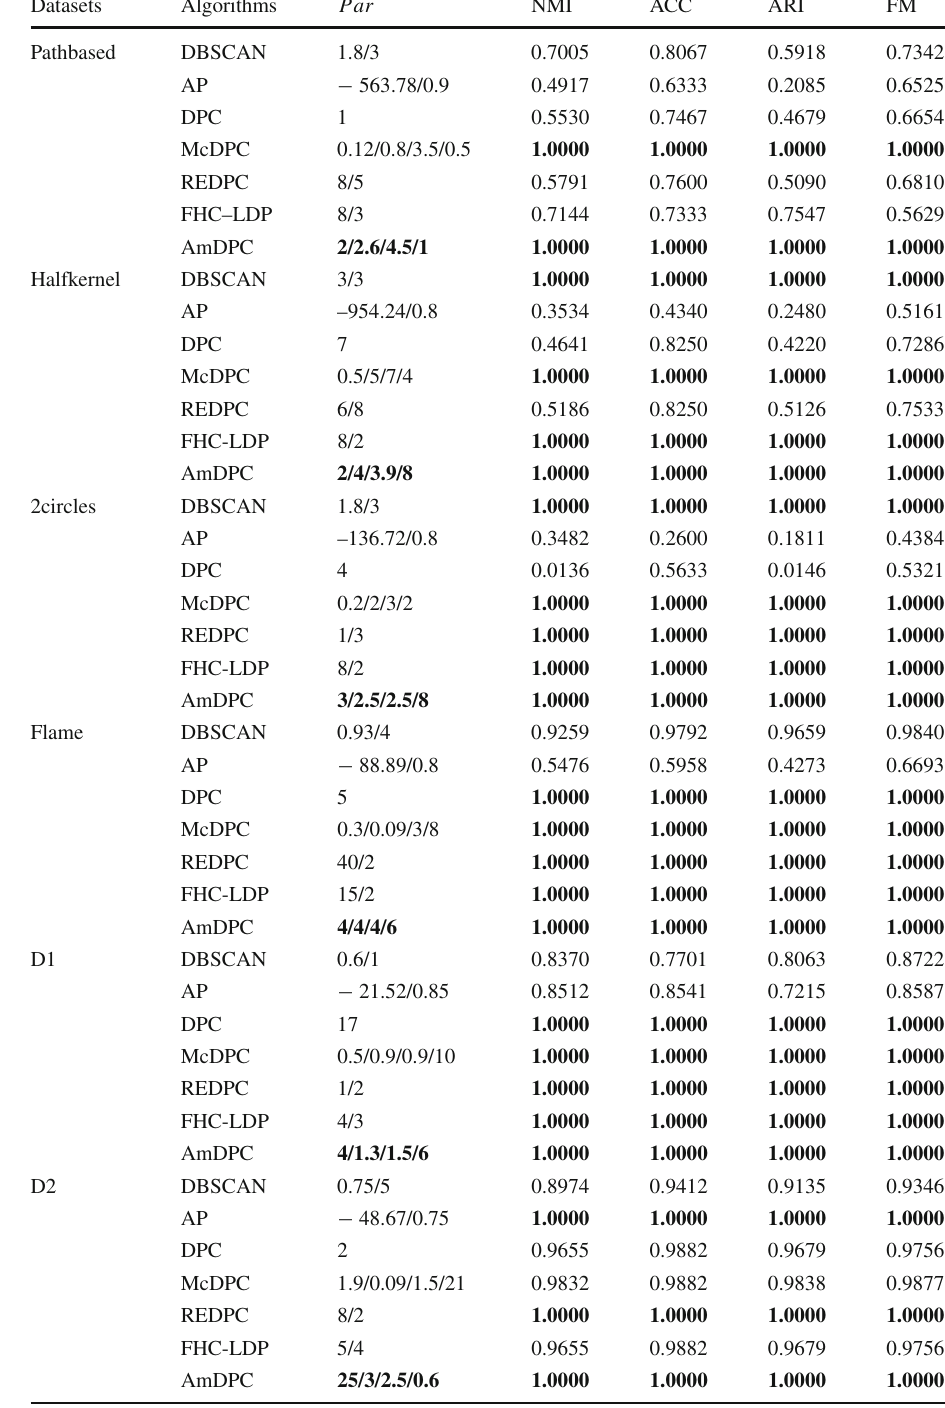
Table 2 The performance of synthetic